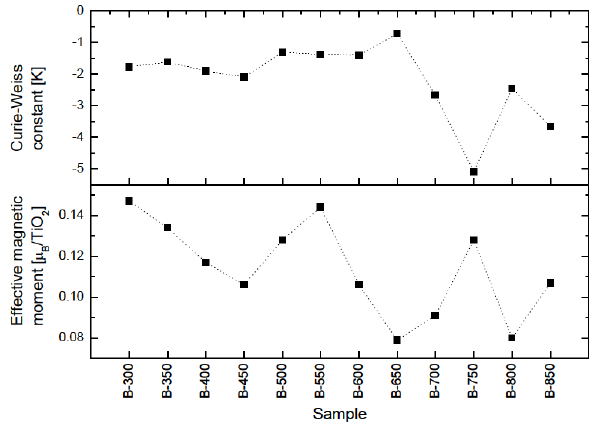
Figure 5: Values of the Curie-Weiss constant (top panel) and the effective magnetic moment (bottom panel) of the low-temperature component χ 3 in all investigated samples.